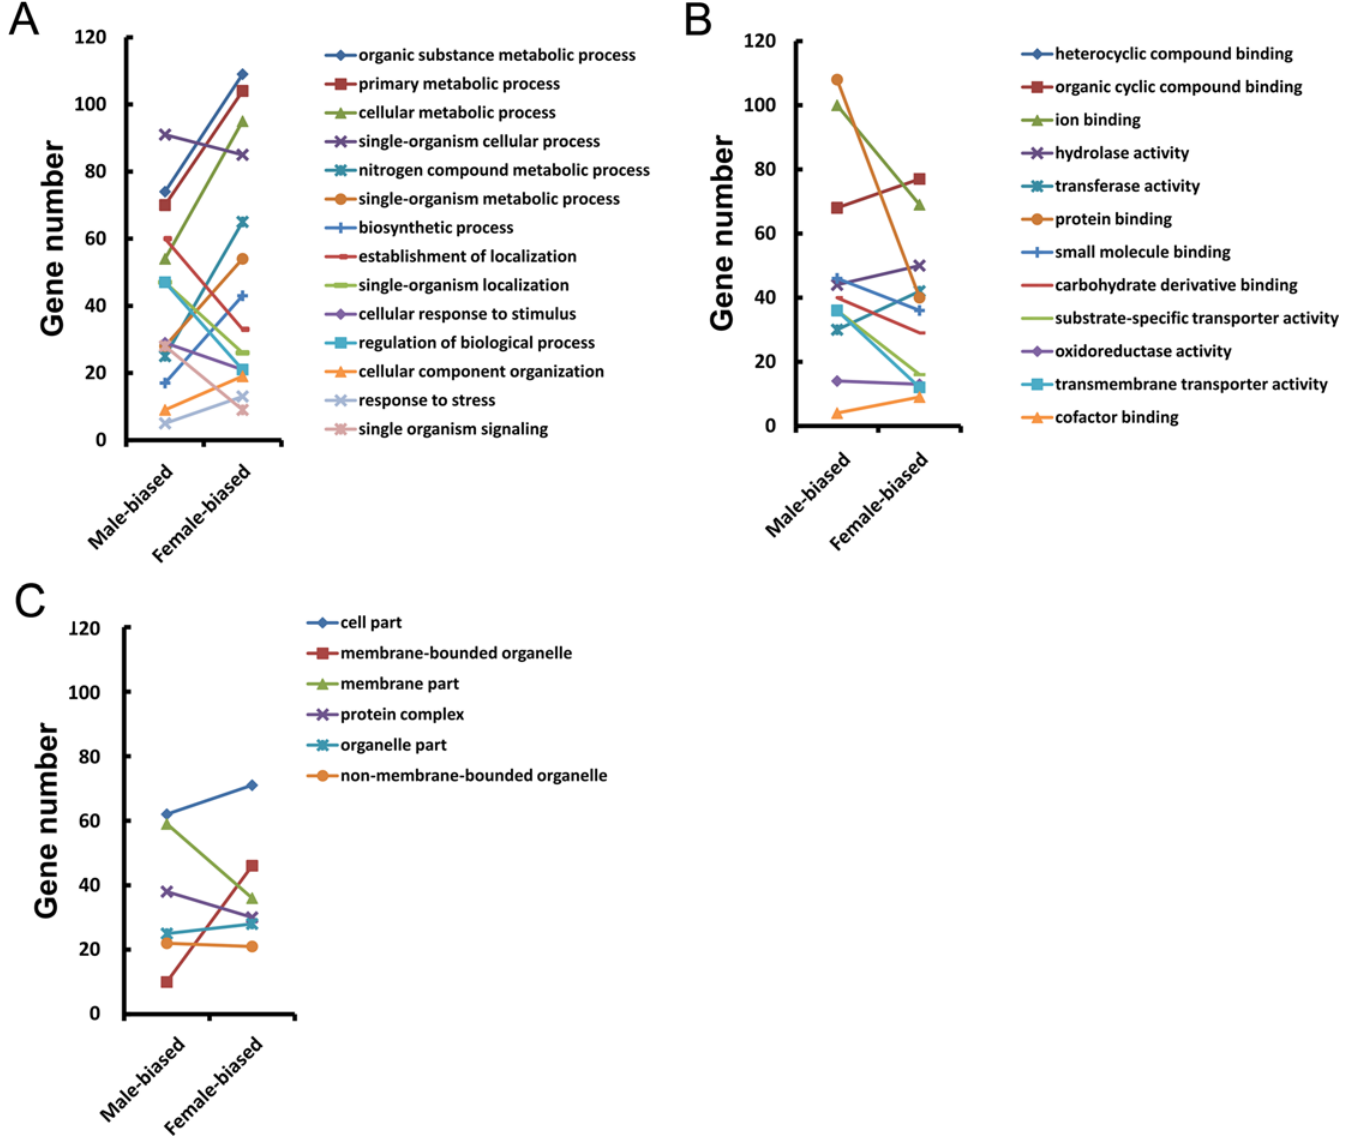
Fig 4. GO distribution for gender-biased expressed genes. The Blast2Go program defined the GO terms into three categories: A. biological processes; B. molecular functions; C. cellular component.